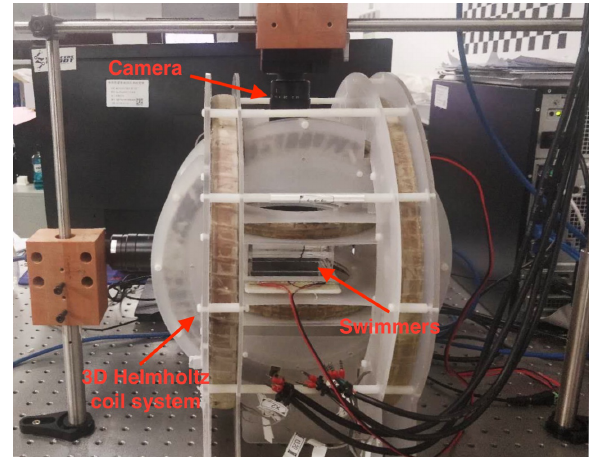
Figure 2. Experiment